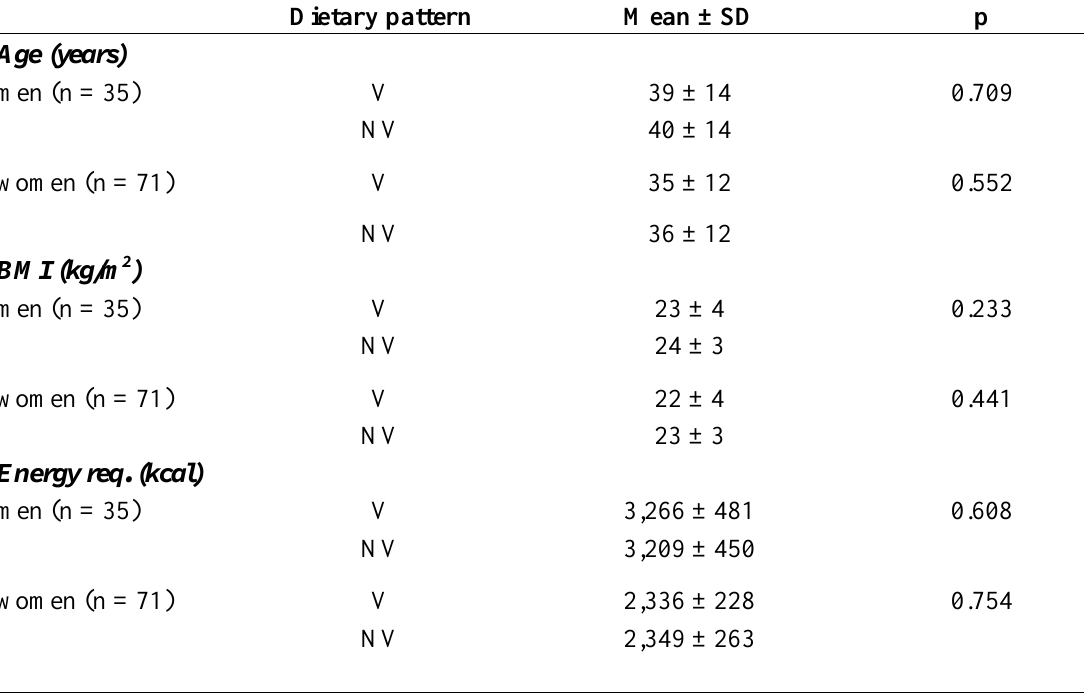
Table 1. Age, BMI and energy requirement of the vegetarian (V) and the omnivorous (NV)